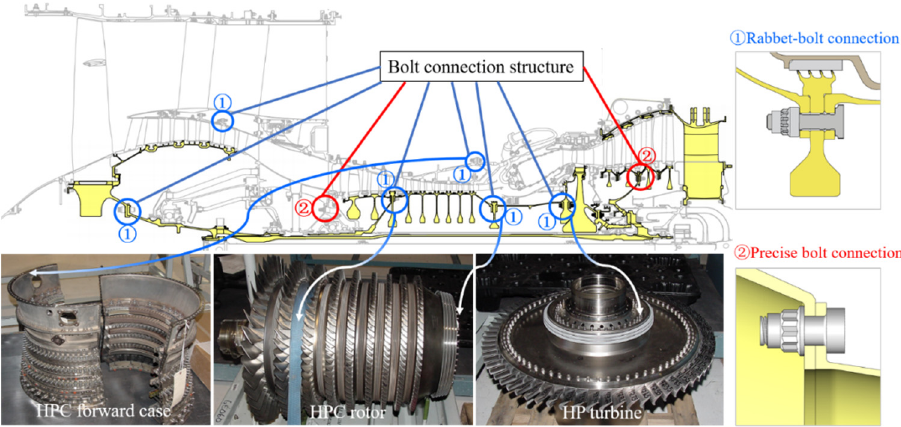
Figure 1. Typical aeroengine bolt connection structure distribution and location diagram.